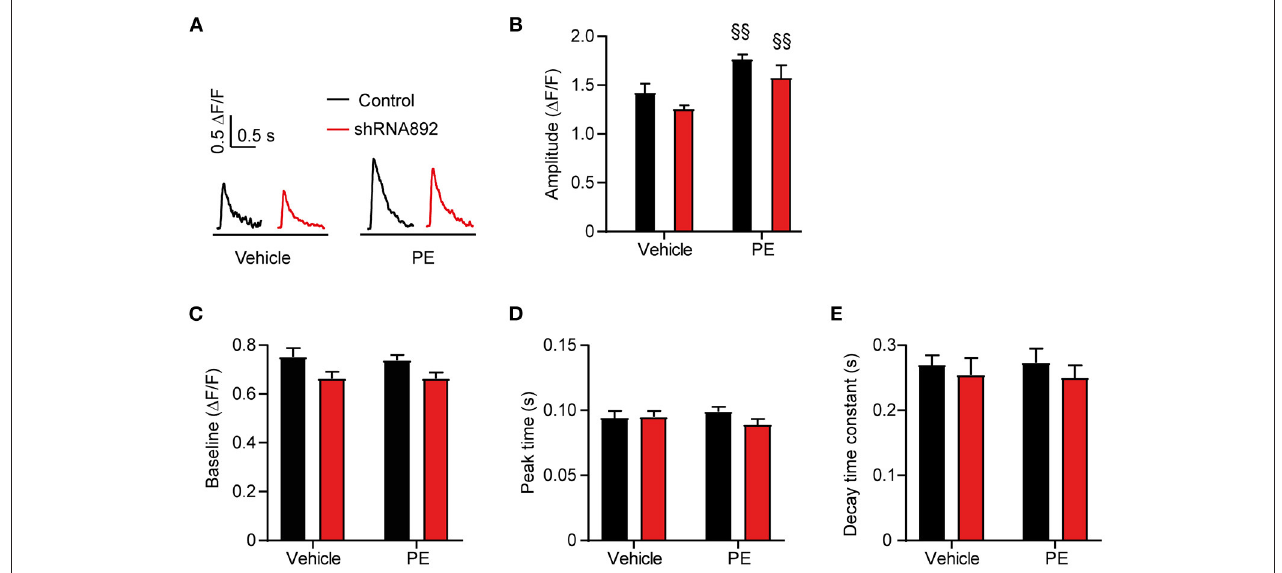
FIGURE 2 | Analyses of calcium transients in control and Ca v β 2 -downregulated NRCs after vehicle or PE treatments. (A) Representative calcium transients of control (shRNAsc) and Ca v β 2 -downregulated NRCs (shRNA892) treated with vehicle or 50 µ M phenylephrine (PE) and stimulated at 1.0Hz. (B–E) Bar plots of the mean values of the effect of vehicle or PE treatments on the diastolic calcium, amplitude, peak time, and decay time constant of the calcium transients in control or Ca v β 2 -downregulated NRCs. Mean ± SEM; n = 11–14 cells per group from 3 different NRC isolations; §§ p < 0.05 vs. vehicle-treated cells in the same group (two-way ANOVA with Holm–Sidak’s